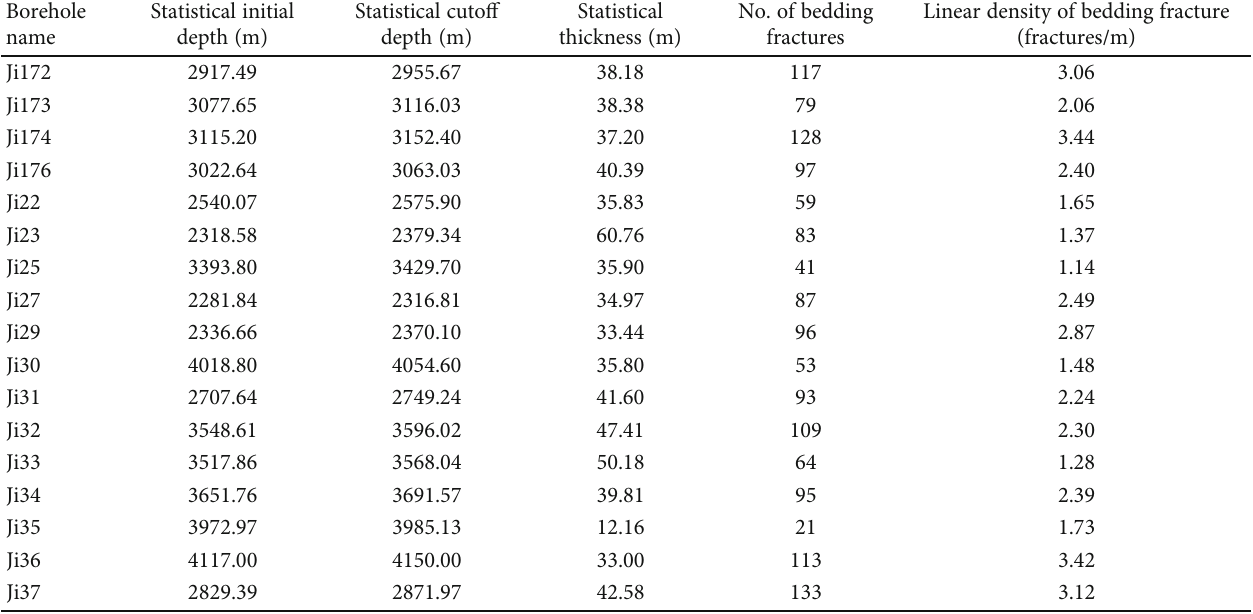
Table 1: Statistic of linear density of bedding fractures in the upper sweet spot of Lucaogou formation in Jimsar sag. Borehole